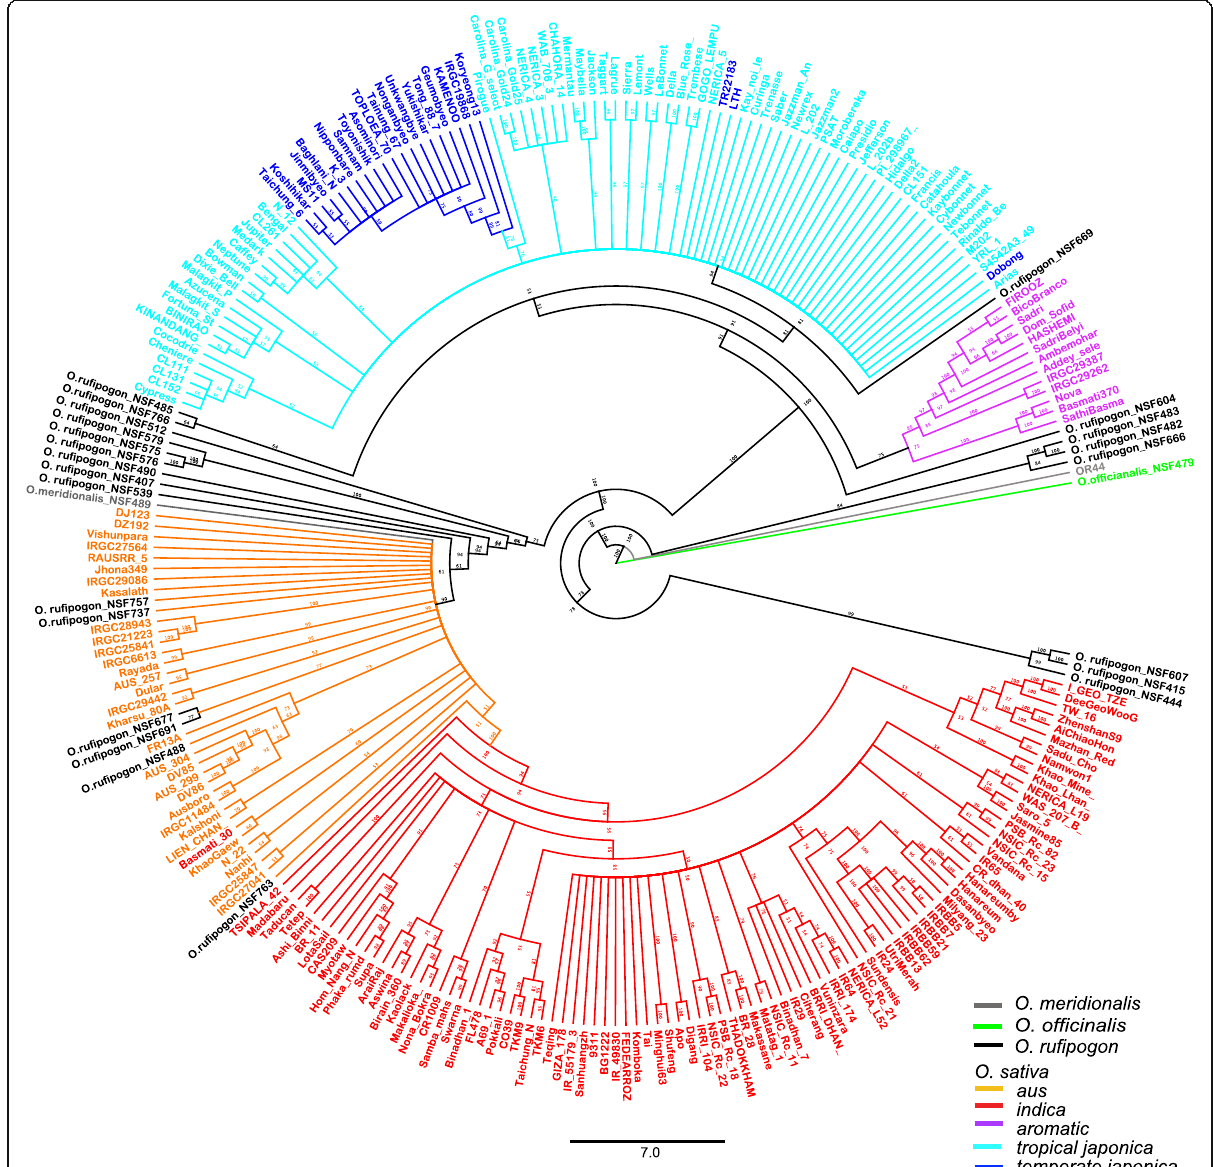
Fig. 4 Distance tree constructed using the Neighbor-Joining method based on 232 Oryza sativa , 23 Oryza rufipogon , 2 O. meriodionalis (AA genome) and 1 Oryza officinalis (outgroup) accessions.A total of 4940 SNP data points from the C6AIR was used for the analysis and the number at the nodes indicate boot- strap value (100 replicates). The colors in the tree correspond to species and subpopulations; Oryza officinalis indicated in light green; O. meriodionalis in dark green; Oryza rufipogon in black, and the five subpopulations of Oryza sativa are in orange ( aus ), red ( indica ), purple ( aromatic or Group V ), cyan ( tropical japonica ) and blue ( temperate japonica